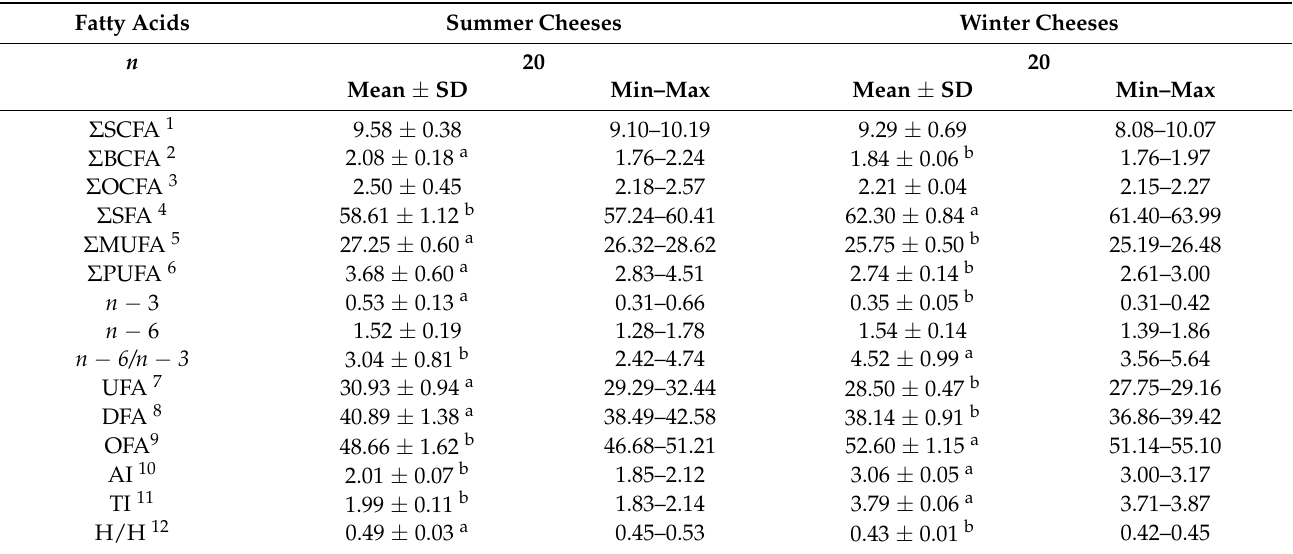
Table 4. Mean ± SD of sum of fatty acids (% of total fatty acids) and nutritional indices in summer and winter cheeses made from cow’s